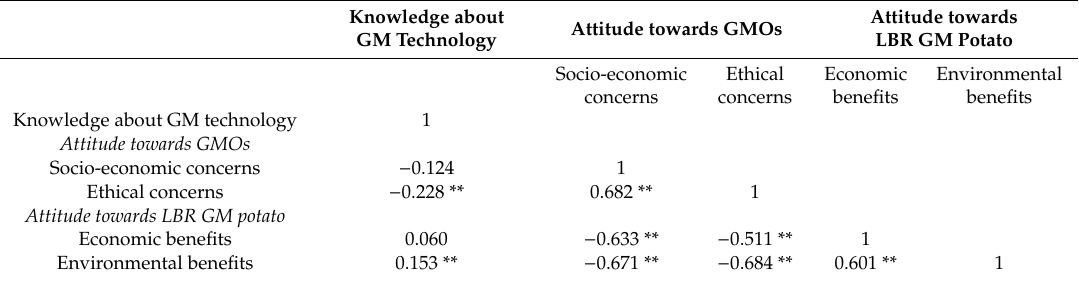
Table 1. Bivariate correlations between the attitudinal explanatory variables in the model ( n = 384).